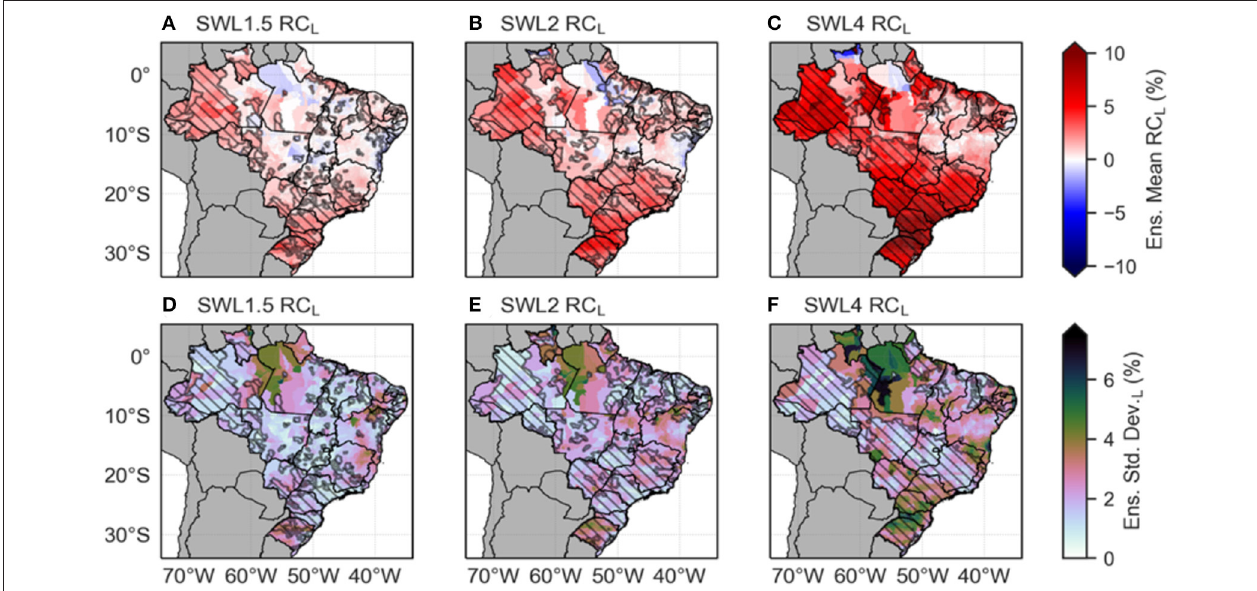
FIGURE 3 | Geographical distribution of the ensemble mean (A–C) and standard deviation (D–F) relative changes of the potential impact index for landslides (RC L ) with respect to the historical period for various scenarios: (A,D) GWL1.5; (B,E) 2.0; and (C,F) 4.0. The hatch pattern represents areas where the ensemble sign agreement presents values above or below + 66 or − 66%,